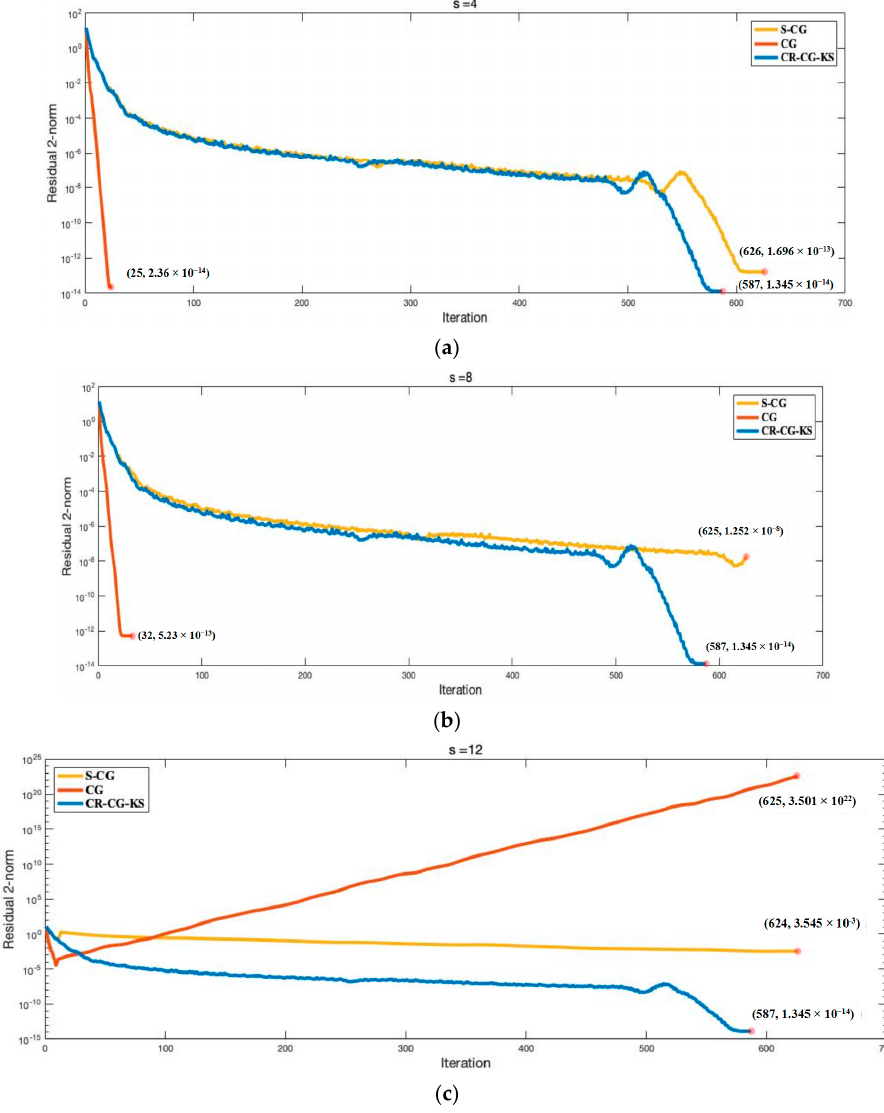
Figure 4. Algorithm iterative process comparison (625 ports): ( a ) S = 4 ( b ) S = 8 ( c ) S = 12.